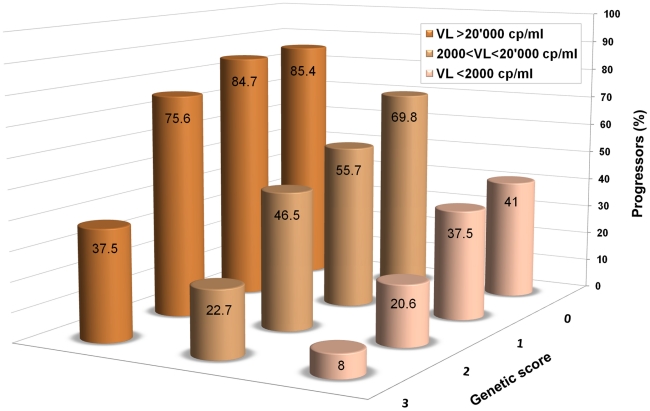
An additive genetic score helps predict HIV-1 disease progression.Data are from Fellay et al. [7]: 1,071 individuals of Caucasian ancestry with HIV-1 are included in the analysis. The columns show the proportions of individuals that reached a progression outcome (CD4+ T cells <350/ul or initiation of combined antiretroviral treatment with CD4+ T cells <500/ul) during the first 5 years after estimated date of seroconversion in categories defined by HIV-1 viral load and by a simple additive genetic score, in which one unit is counted for each “protective” allele. The minimum score is 0 for individuals that are homozygous for the major allele at rs2395029 (a proxy for HLA-B*5701), rs9264942 (HLA-C -35 variant), rs9261174 (ZNRD1), and CCR5-Δ32. The maximal observed score is 3 since no individual was heterozygous or homozygous for the minor allele at all four sites. Individuals were grouped in three categories to clearly show that the genetic score refines the prediction of progression, beyond the information provided by viral load only, throughout the range of set point values.